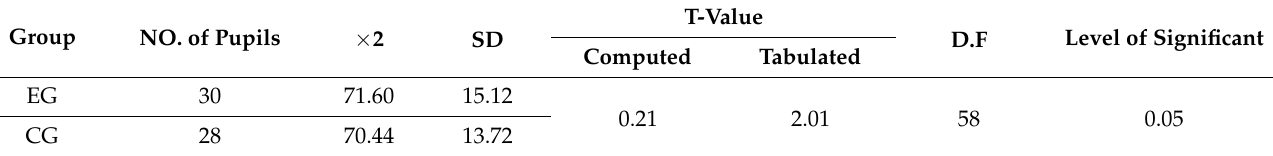
Table 7. The Mean, Standard Deviation, and T-Value of Pupils’ Scores in the Pretest.